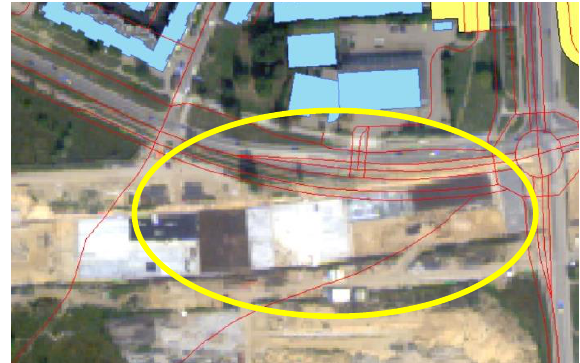
Figure 2. New road under construction. The red lines define objects in the Topographical Database.